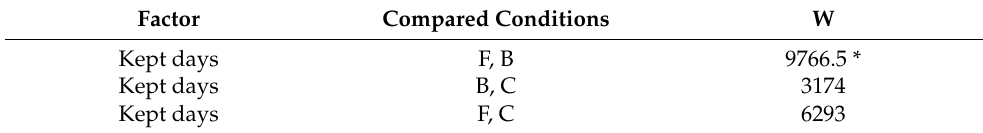
Table 12. Post-hoc Mann–Whitney tests results for kept days in Non-Beginners. Factor Compared Conditions W Kept days F, B 9766.5 * Kept days B, C 3174 Kept days F, C 6293